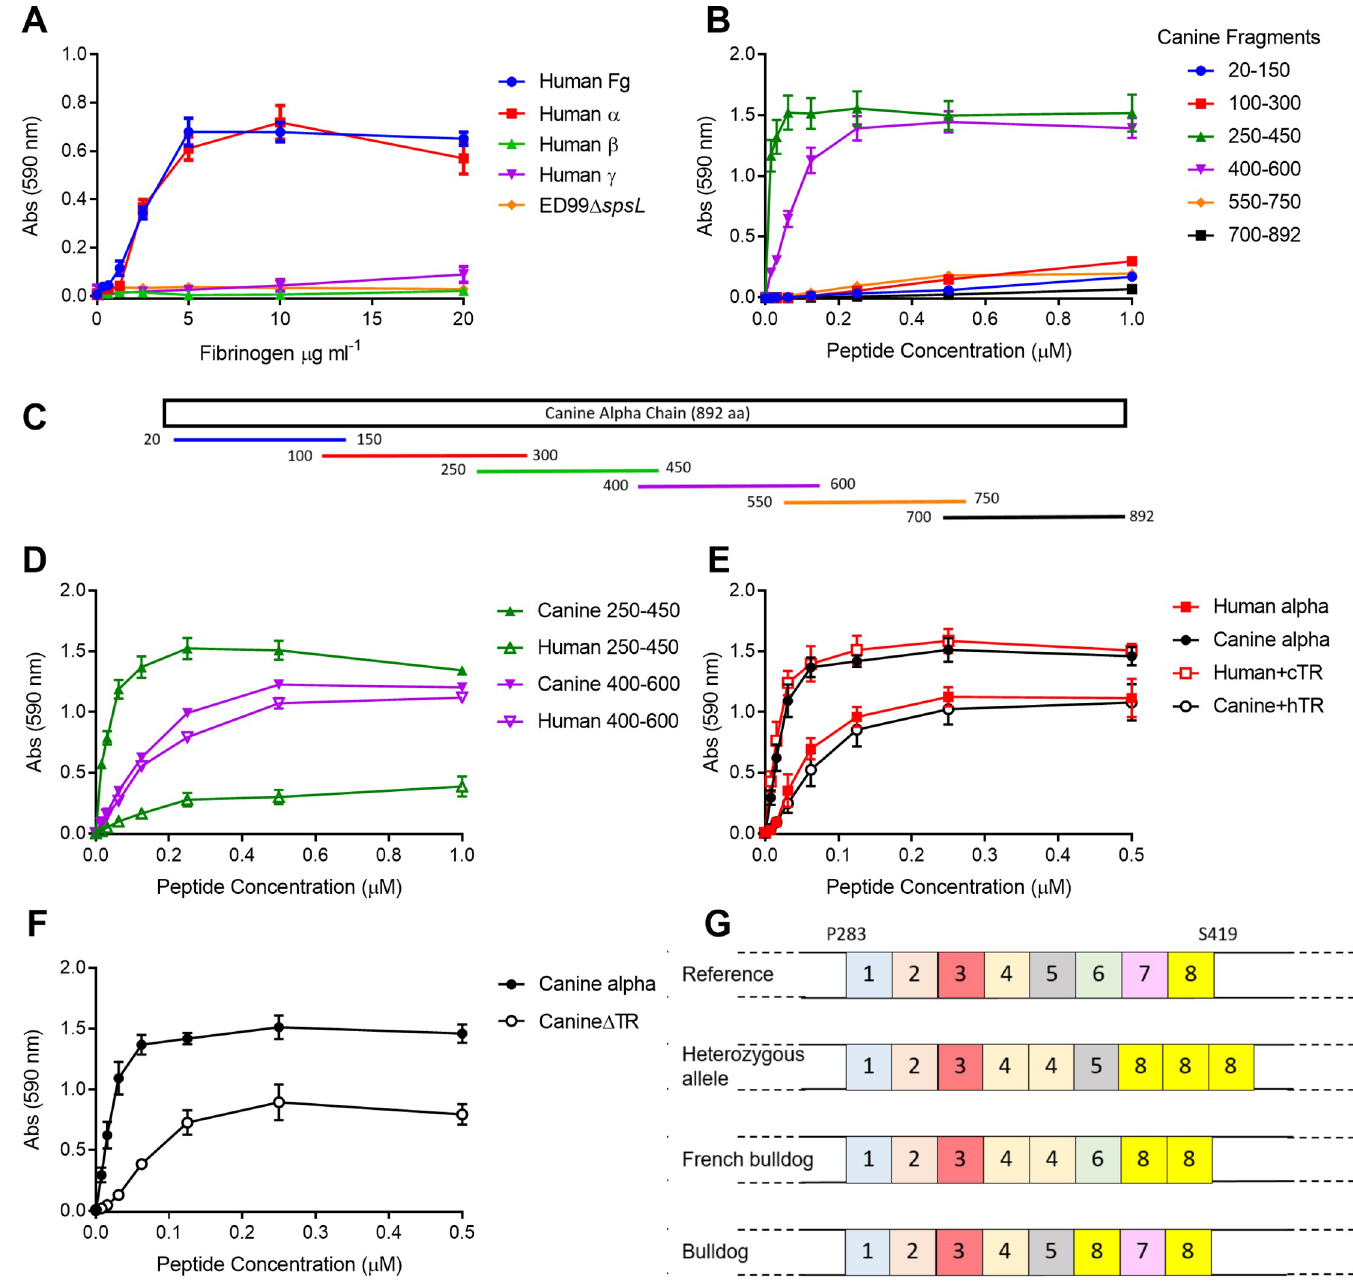
Fig 4. SpsL binds strongly to the tandem repeat region of the canine fibrinogen α -chain. (A) Adherence of ED99 Δ spsD to human recombinant fibrinogen chains using crystal violet staining. (B, D, E, F) Adherence of SpsL expressed in ED99 Δ spsL Δ spsD to fragments, chimeras, or deletion constructs of the canine and human fibrinogen α -chains. All data points represent the mean with error bars representing SEM (n = 9). (C) Schematic of the overlapping fragments generated in the canine α - chain. (G) Schematic of the diversity in the tandem repeat region of the canine fibrinogen α -chain in 11 canine breeds.